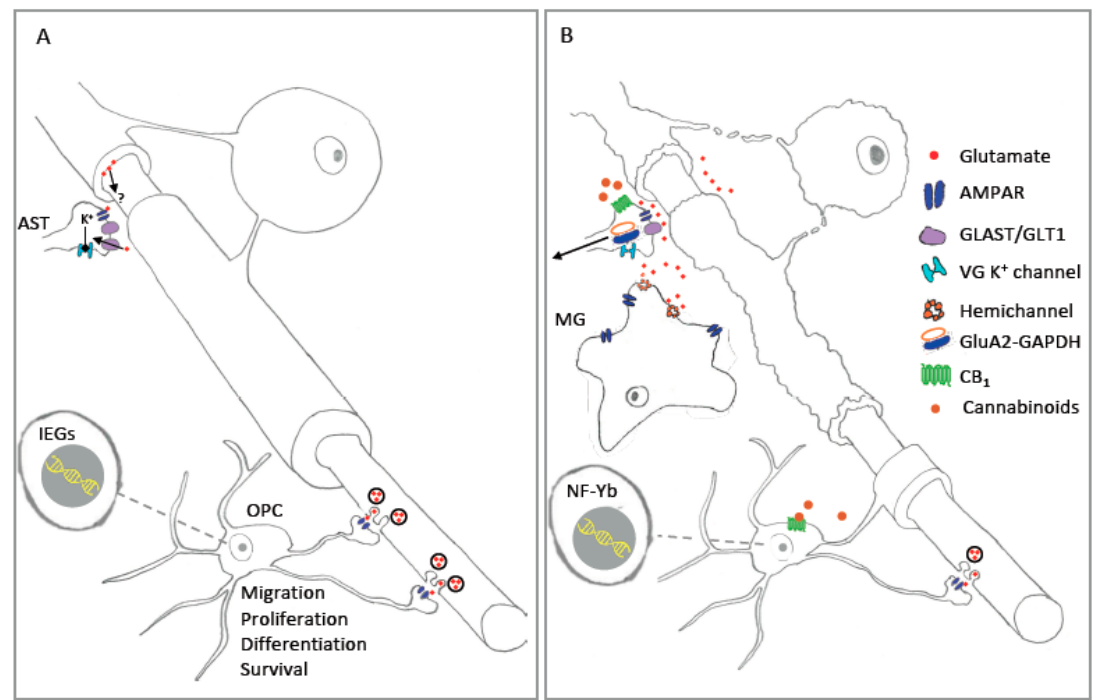
Figure 1. AMPAR functions for CNS white matter glia in health and disease. ( A ) Illustration depicting the interaction of glial elements in CNS white matter. Astrocytes (AST) and oligodendrocyte progenitors (OPC) extend processes that make contact with unmyelinated axons and the nodes of Ranvier on myelinated axons. These glial processes contain functional AMPAR since white matter astrocytes exhibit AMPAR-mediated Ca 2 + signals, and OPC display AMPAR-mediated synaptic currents. Both unmyelinated and myelinated axons release glutamate via vesicular mechanisms. Glutamate released at unmyelinated axons drives synaptic input on OPC, but it is unclear whether glutamate released at internodal sites di ff uses in concentrations su ffi cient to activate glial AMPAR at nodes of Ranvier. The functional consequences of astrocyte AMPAR in white matter remains unknown but may include a role in the regulation of outward K + currents. AMPAR activation influences multiple functions in OPC including migration, proliferation, di ff erentiation and survival. In addition, AMPAR activation in OPC influences events in the nucleus including the induction of immediate early genes involved in cellular growth. Note, OPC actions depicted also occur in CNS grey matter. ( B ) Depiction of excitotoxic events and glial cell injury in CNS white matter. Excitotoxic and in inflammatory conditions involve an increase in extracellular glutamate levels that damage OL and myelin internodes. Glutamate is released from damaged axons and from gap-junction hemichannels on activated microglia. Excessive astrocyte AMPAR activation may aggravate excitotoxic conditions via the downregulation of astrocyte GLAST. Myelin can be restored by OPC recruited to demyelinated axons. GluA2-GAPDH complexes formed in astrocytes at inflammatory demyelinating lesions may undergo nuclear translocation leading to the initiation of disease processes. Myelin repair involves the recruitment of OPC to demyelinated axons where they establish AMPAR-mediated synaptic connections. Axon-OPC synapses may play a role in guiding OPC to target axons, and in controlling their di ff erentiation into myelinating OL. The modulation of the Endocannabinoid System is able to prevent several of these pathogenic pathways. Either the increase of endocannabinoid tone, or the direct agonism of CB 1 receptors, reduces cytosolic Ca 2 + influx in the oligodendrocyte after an AMPA stimulus. Similarly, increased AEA tone prevents GLAST and GLT-1 downregulation in a mechanism that involves at least CB 1 receptor, and AEA tone increase or CB 1 / CB 2 agonism potentiates GLAST and GLT-1 expression in mouse models of MS. Note, other cytotoxic mediators involved in inflammatory demyelination, such as cytokines and complement cascade components are not shown for clarity.